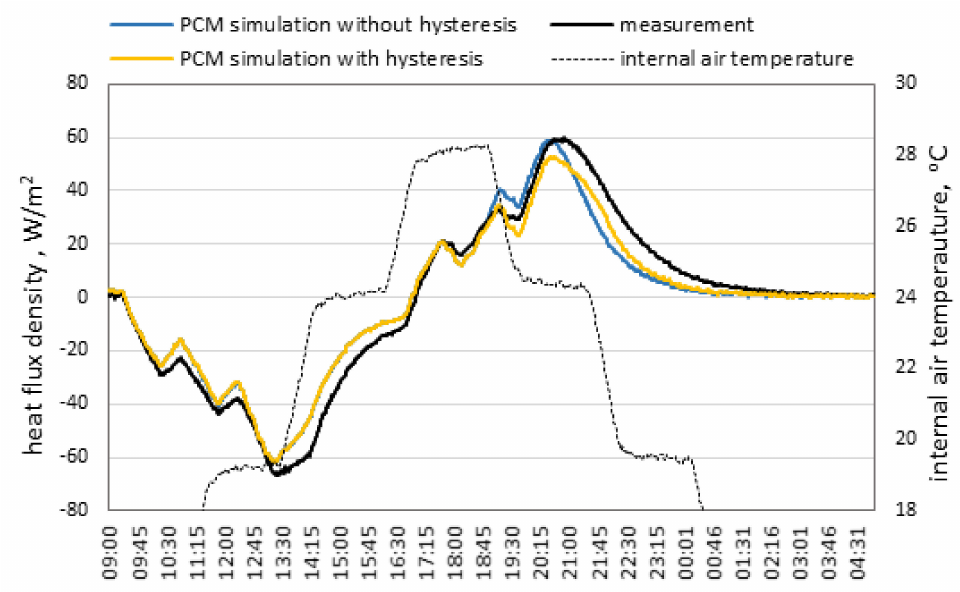
Figure 5. Measured versus simulated heat flux density on the internal surface of the PCM panel.